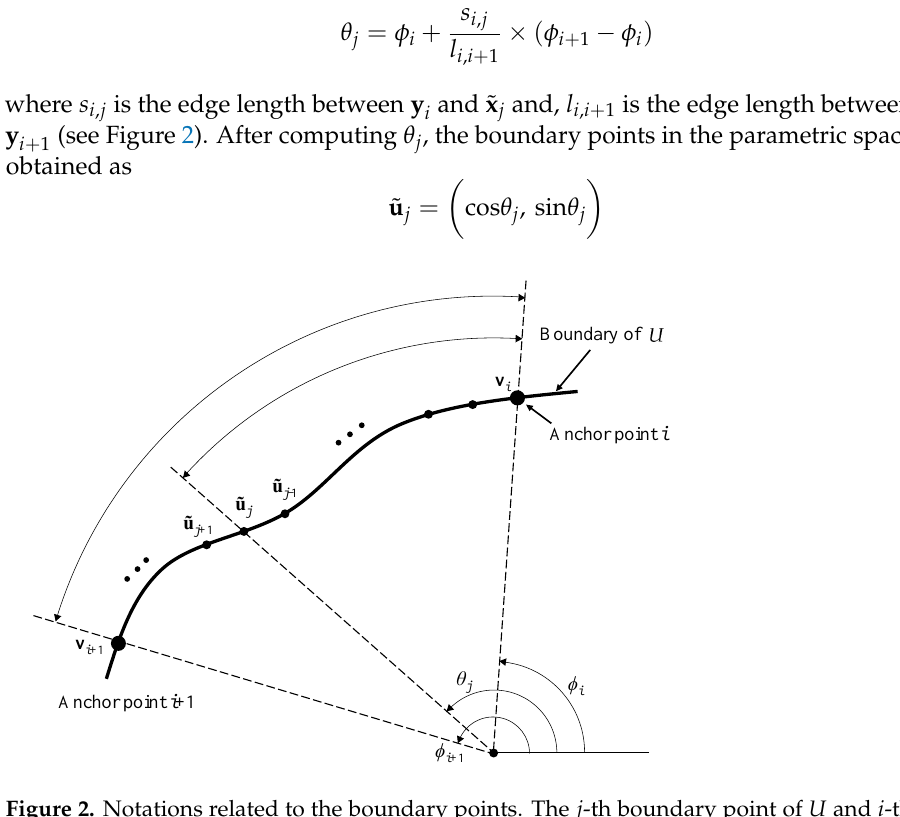
Figure 2. Notations related to the boundary points. The j -th boundary point of U and i -th anchor point located on the boundary are defined as ˜ u j and v i , respectively. Their azimuthal angles are defined as θ j and φ i , respectively, in the current